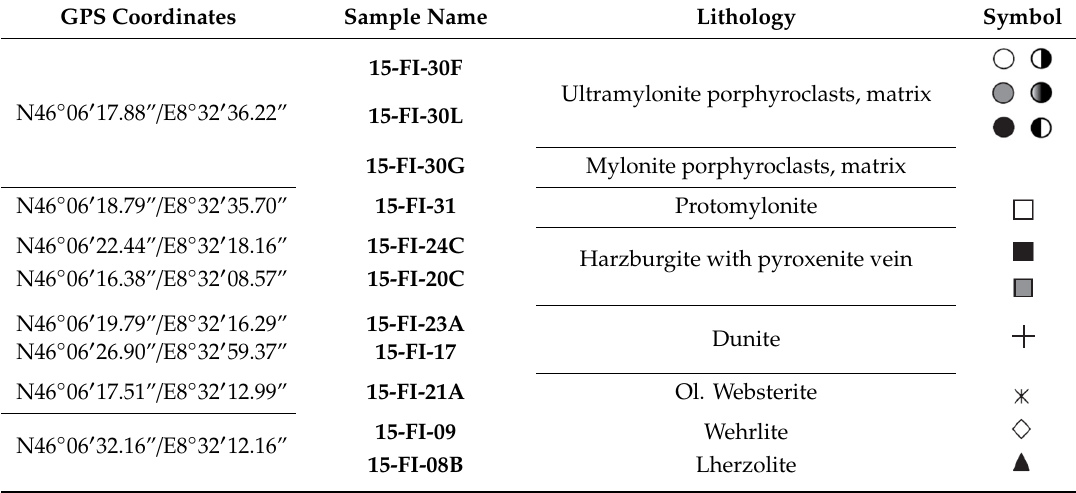
Table 1. Labels, GPS coordinates (WGS84), lithologies of samples, and relative symbols used in diagrams. Table1. Labels, GPScoordinates(WGS84), lithologiesofsamples, andrelativesymbolsusedindiagrams.